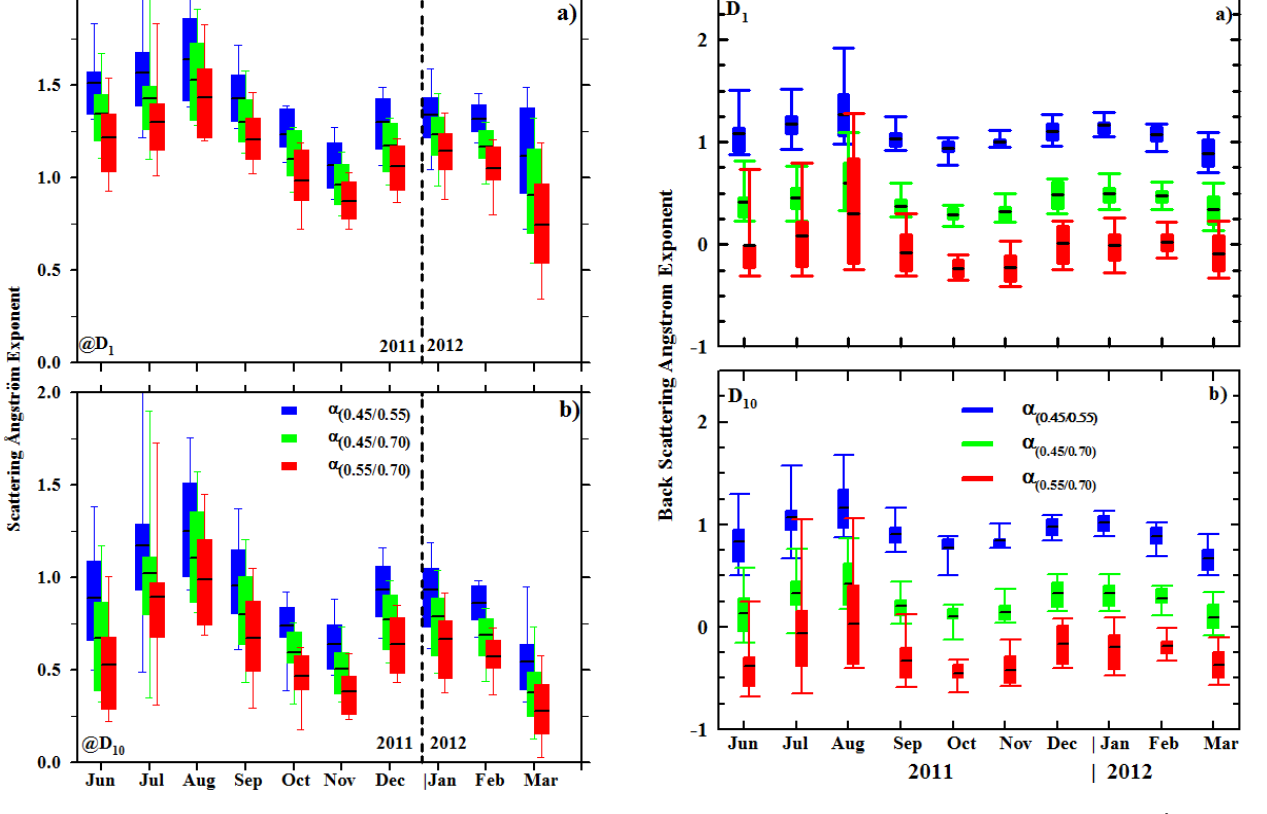
Figure 2. Monthly-mean variation of scattering Ångström exponent for D 1µm (a) and D 10µm (b) during June 2011 to March 2012. The box-and-whisker plots denote the 95th and 5th percentiles, respec- tively. The box’s upper and lower limits are the 75th and 25th per- centiles; the straight black line shows the mean value and the verti- cal dotted line separates the years 2011 and 2012.